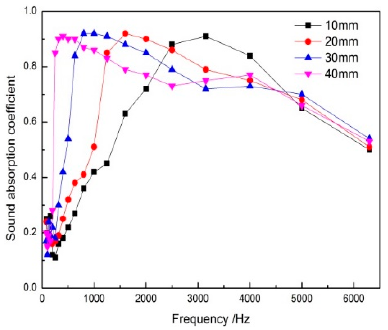
Figure 7. E ff ect of thickness of composites on sound absorption coe ffi cient. Figure 7. Effect of thickness of composites on sound absorption coefficient.